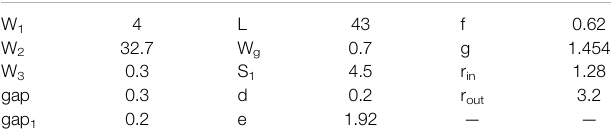
TABLE 3 | Parameters of bandpass fi lter with CPW structure based on SRR (unit: mm) (optimized). Parameter values of bandpass fi lter with CPW structure based on SRR (unit: mm)